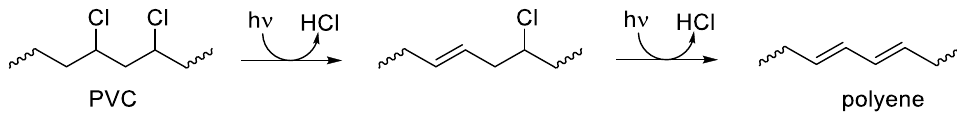
Figure 2. Dechlorination of PVC and formation of polyene polymeric chains.